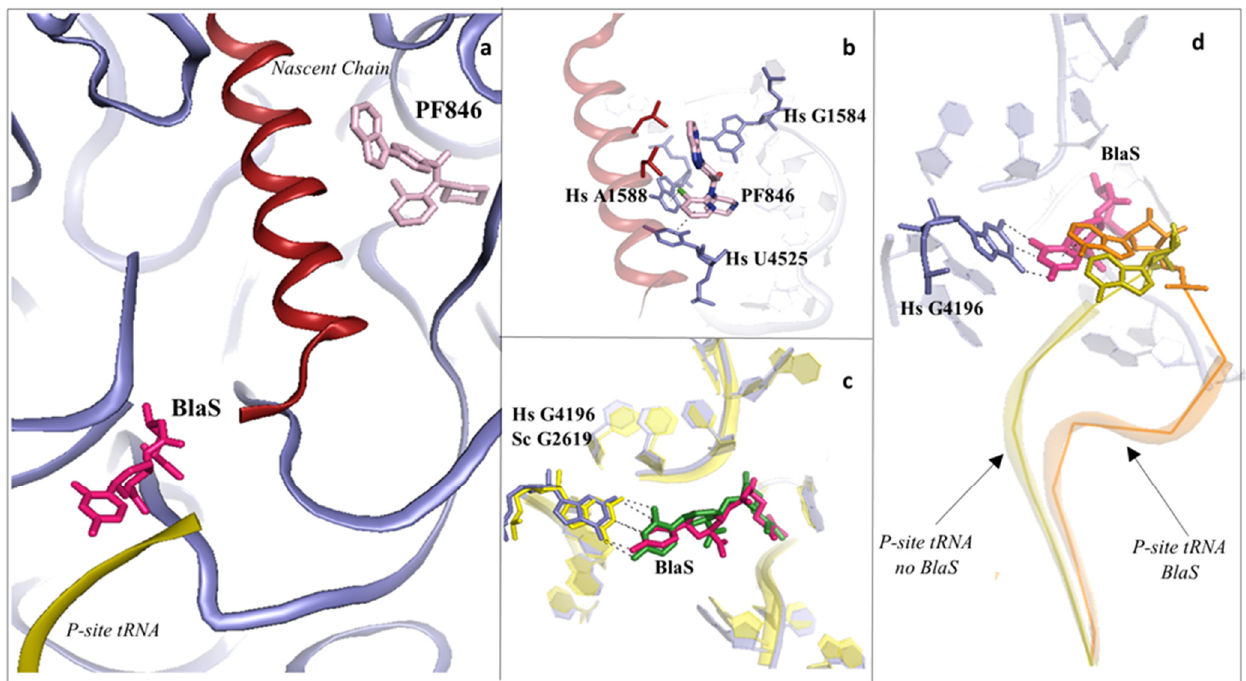
Figure 4. Inhibitors binding to the PTC impair elongation of the nascent chain and can be sequence specific. ( a ) Overview of the PTC and peptide exit tunnel (PET) of the human ribosome. Blasticidin S (BlaS) in green and hot pink (PDB: 4U56 Sc/7NWI Hs) and PF846 in light pink (PDB: 6XA1) bind within the PTC, where the P-site tRNA and nascent chain, respectively, interact with the ribosome; ( b ) PF846 binds to the PET and contacts residues A1588 and U4525 by establishing two different types of interactions, halogen– π and π – π stacking, respectively, each mediated by the chloride atom; ( c ) structural superimposition of human and yeast ribosomes solved in complex with BlaS. The conserved residue G4196 (G2619 yeast numbering) establishes a similar hydrogen bonding network with the compound in both organisms; ( d ) superimposition of translating human ribosome complexes in presence (PDB: 7NWI) and absence of BlaS (PDB: 6XA1). Detail of the displacement of the CCA-end of the P-site tRNA upon binding of the drug, which further promotes an additional π – π stacking with A76, likely preventing the correct accommodation of the tRNA into the PTC. P-site tRNA in absence of BlaS is coloured in olive, while the P-site tRNA in presence of BlaS in orange. Hs: H. sapiens .